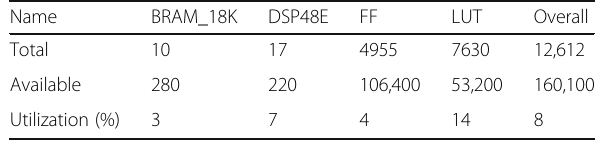
Table 7 Second approach OCR algorithm utilization